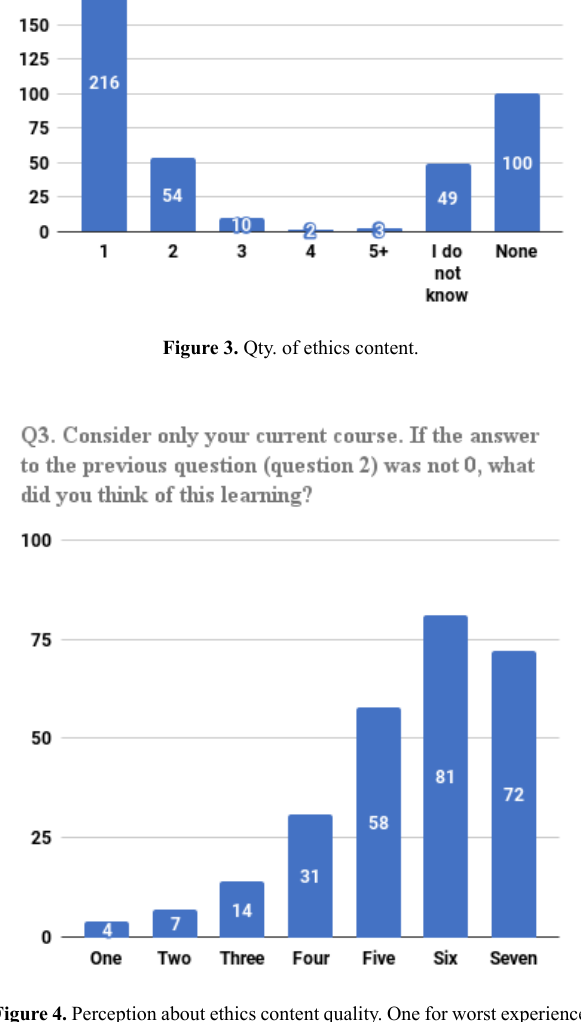
Figure 4. Perception about ethics content quality. One for worst experience, seven for best experience. with the personal data exposed in Section 3, inconsistencies and conflicts between the data